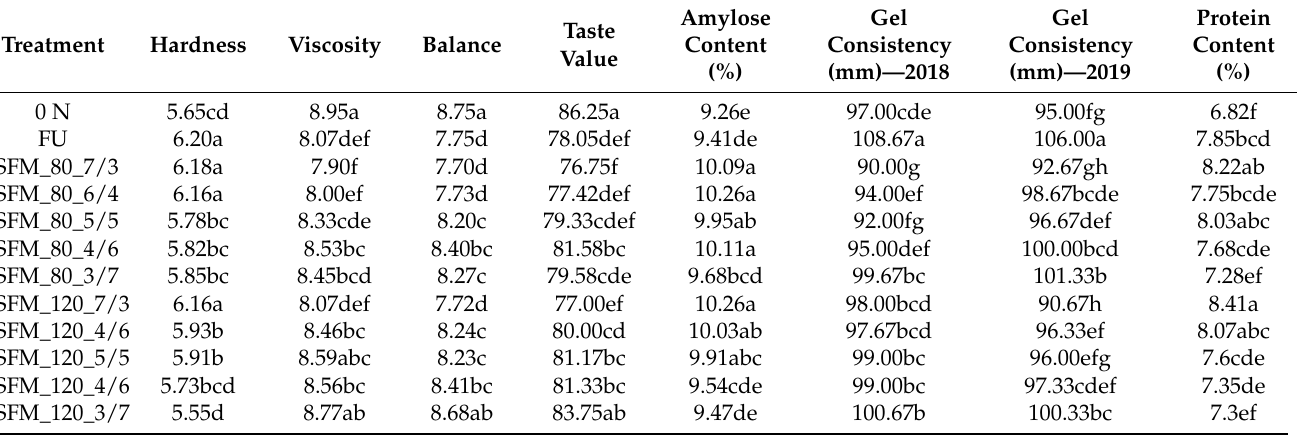
Table 8. Effects of different fertilization modes on rice eating quality, amylose content, and gel